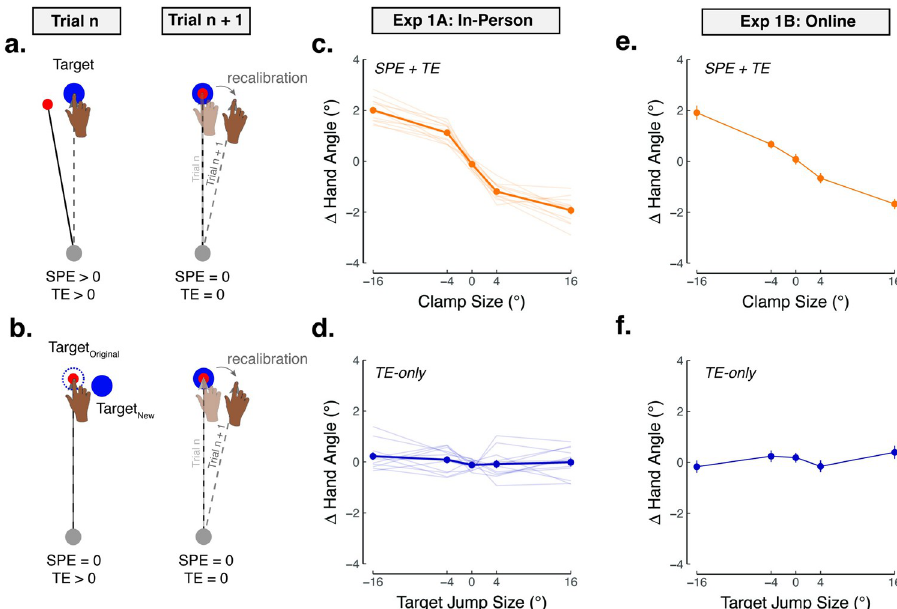
Fig 2. Task error alone does not elicit implicit recalibration (Exp 1). Using clamped visual feedback for testing implicit responses to: (a) SPE + TE, induced by offsetting the cursor trajectory at a fixed angle relative to the target (independent of the participant’s heading angle), and (b) task error (TE) only, induced by jumping the target immediately after movement initiation, with the cursor clamped to 0˚ (the original target location; Exp 1A) or with no cursor feedback provided (Exp 1B). Note that for ease of exposition, we illustrated trial n + 1 as a TE-only trial (0˚ clamp paired with a 0˚ target jump); however, trial n + 1 could be another trial type (e.g., 4˚ clamped feedback paired with a 0˚ target jump). (c)–(d) Participants tested in the lab (Exp 1A) experienced alternating blocks of target jumps and clamped feedback (201 trials/block). The perturbation sizes within a given block were randomized to prevent accumulated learning. Adaptation was quantified by measuring how much the hand angle changed on trial n + 1 in response to the perturbation on trial n. (e)–(f) Participants tested online (Exp 1B) experienced a fully randomized schedule of target jumps and clamped feedback trials. Dots connected with thick line represent the across participant average; thin lines represent individual data. Due to the large number of participants in Exp 1B (N = 87), individual participants are not shown for ease of